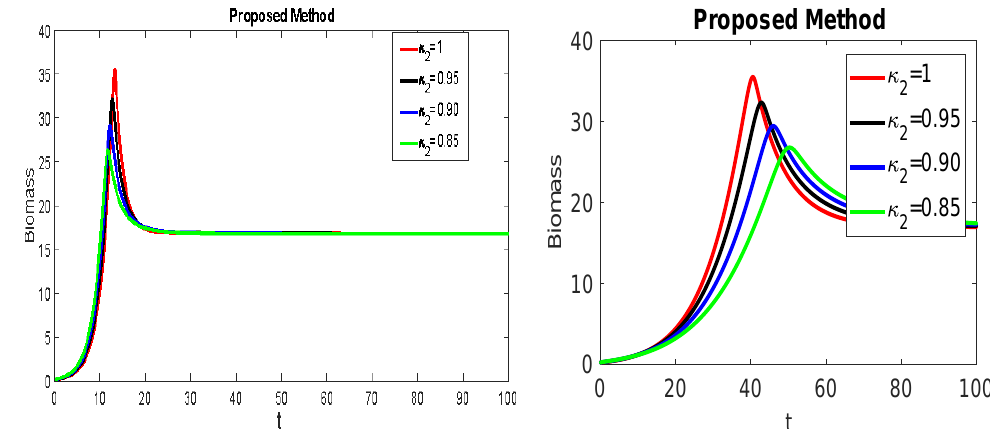
Figure 2. Graphical representation of biomass for different values of κ 1 and κ 2 .